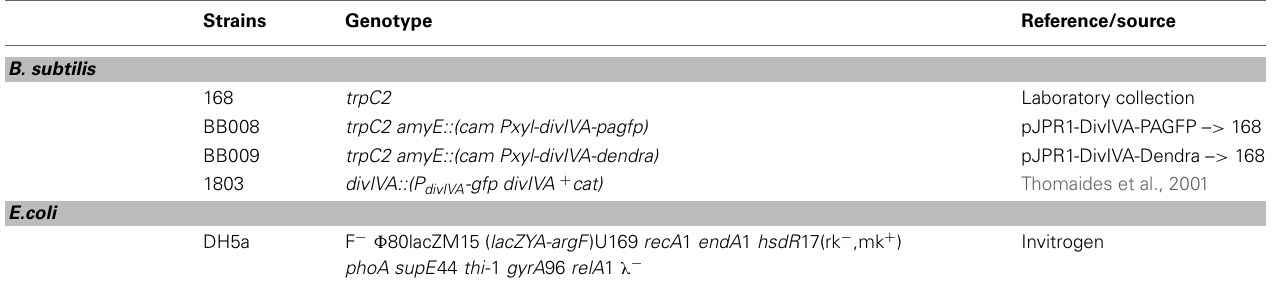
Table 3 | B. subtilis and E. coli strains used in this